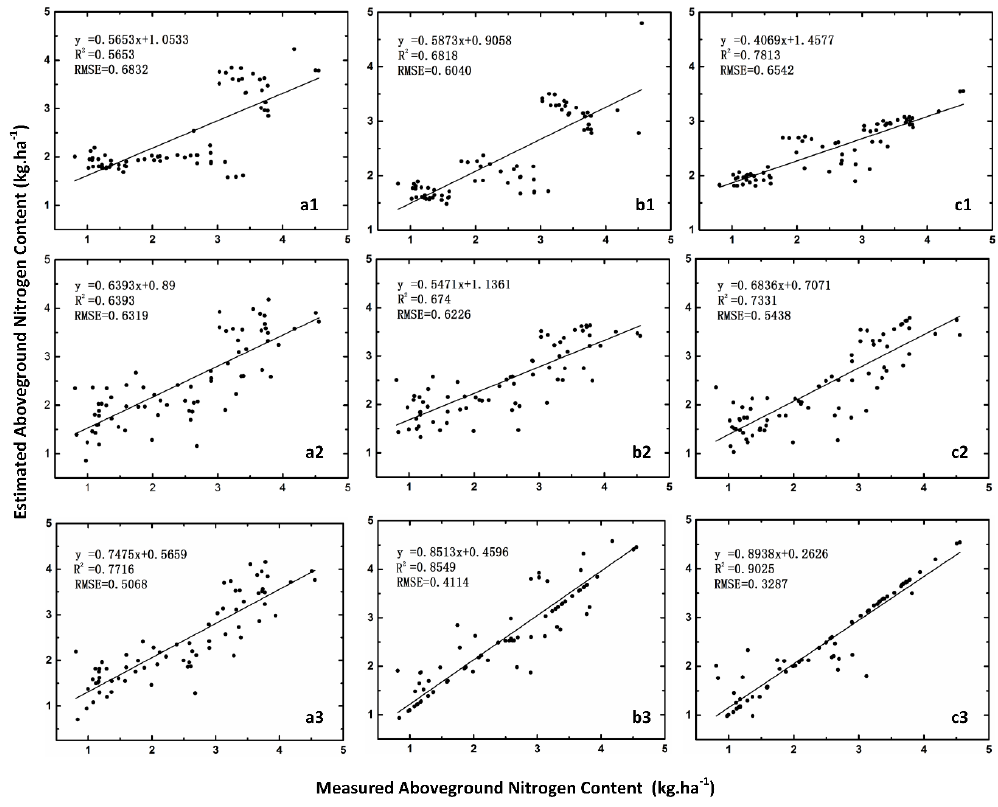
Figure 6. Estimated and measured winter wheat aboveground nitrogen content (kg·ha −1 ). Left: partial least squares regression (PLSR), Middle: support vector regression (SVR), right: particle swarm optimization-SVR (PSO-SVR) with vegetation indices (VIs) alone ( a1 , b1 , c1 ), wavelet features ( a2 , b2 , c2 ), and the combined data ( a3 , b3 , c3 ). The data points displayed make up the validation set. The solid line indicates the fitting function of the scatter plot.